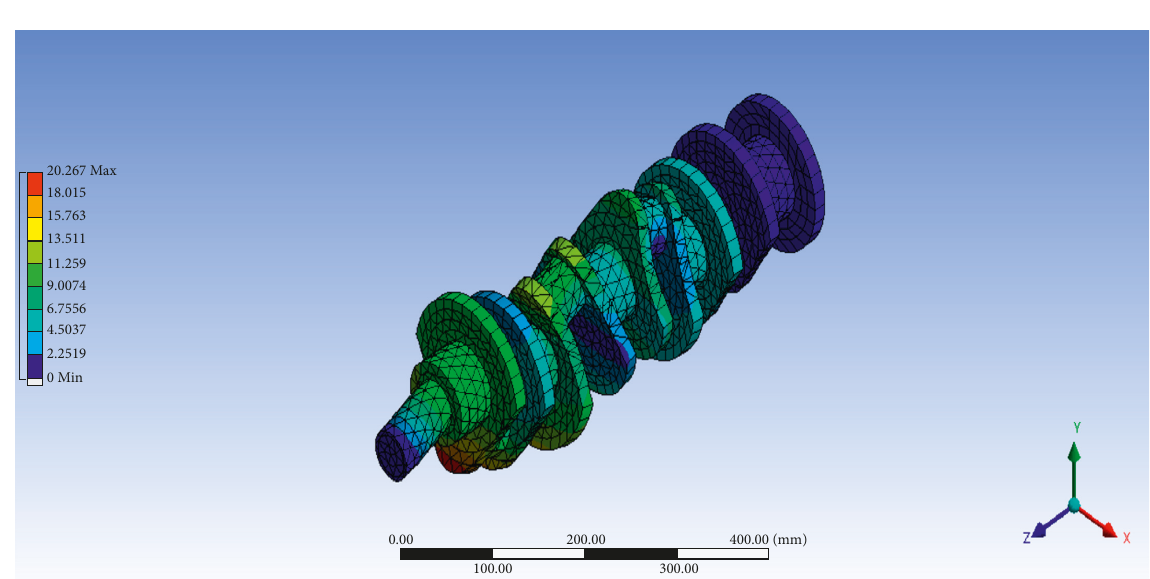
Figure 21: Deformation of FGM crankshaft at the fifth mode of vibration.